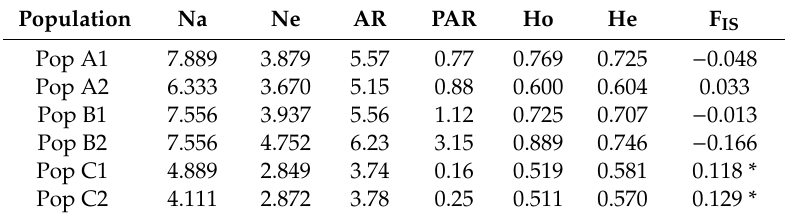
Table 3. Genetic diversity of three population classes (A, B, and C) of Pistacia chinensis . Population